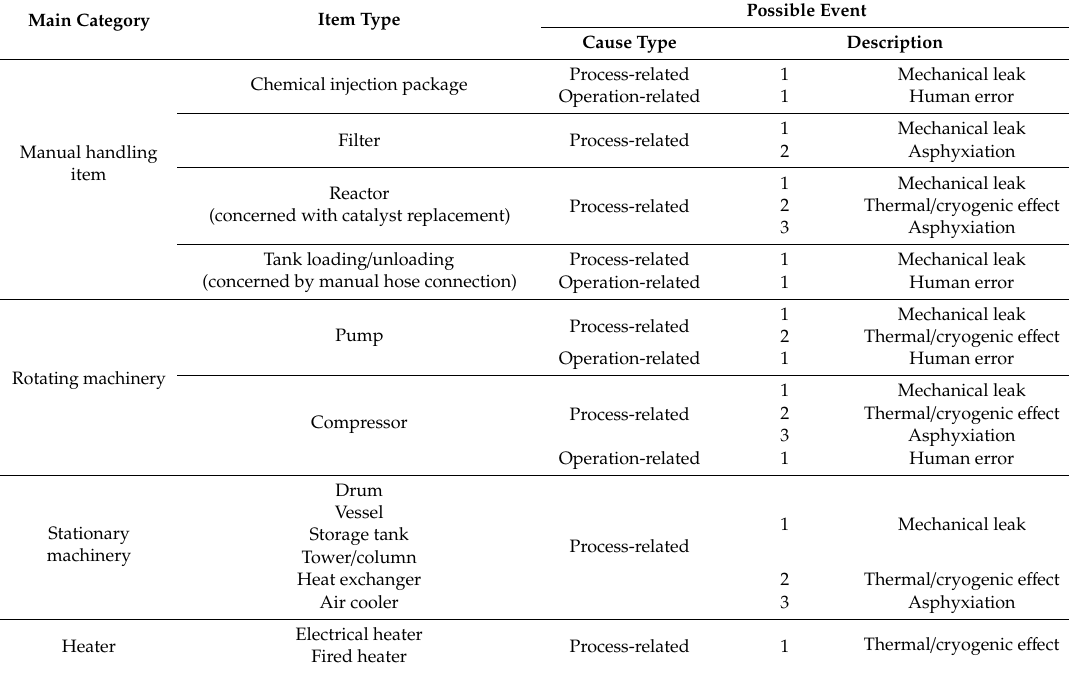
Table 8. Expected risk cause and consequence by item type in HSE Engineering.